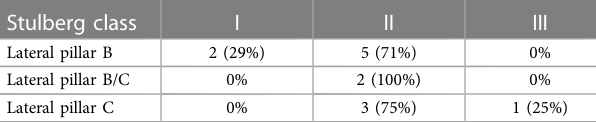
TABLE 2 Stulberg classi fi cation distribution in the fi nal follow-up according to the preoperative lateral pillar classi fi